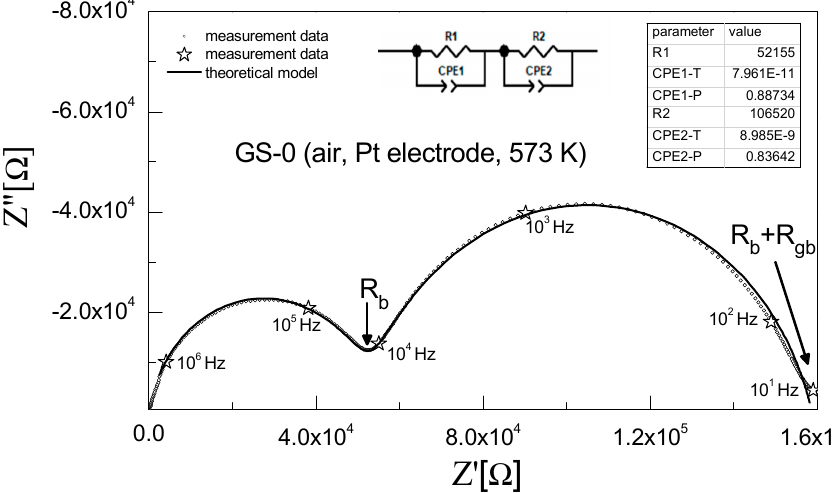
Figure 6. Impedance spectrum recorded at 573 K for the 3Y-TZP sample with no alumina addition (GS-0) and the curve fitted to experimental data.